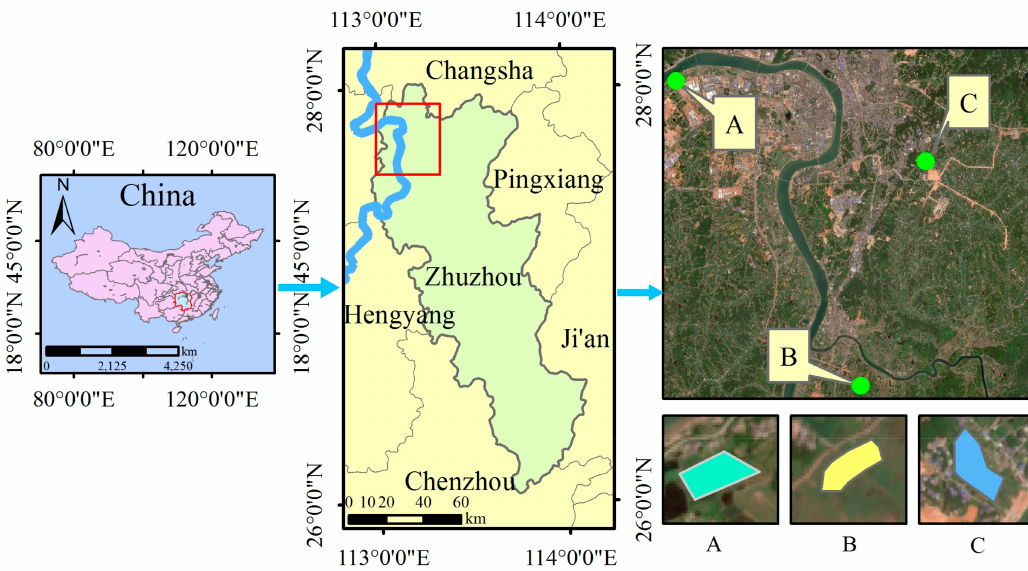
Figure 1. Location of the study areas in the city of Zhuzhou, Hunan Province, China. Table 1. Heavy metal concentration (unit: mg kg − 1 ) in the soil of the three study areas. Study Areas Cd Hg Pb As Pollution Level A (27 ◦ 49 (cid:48) N, 113 ◦ 04 (cid:48)